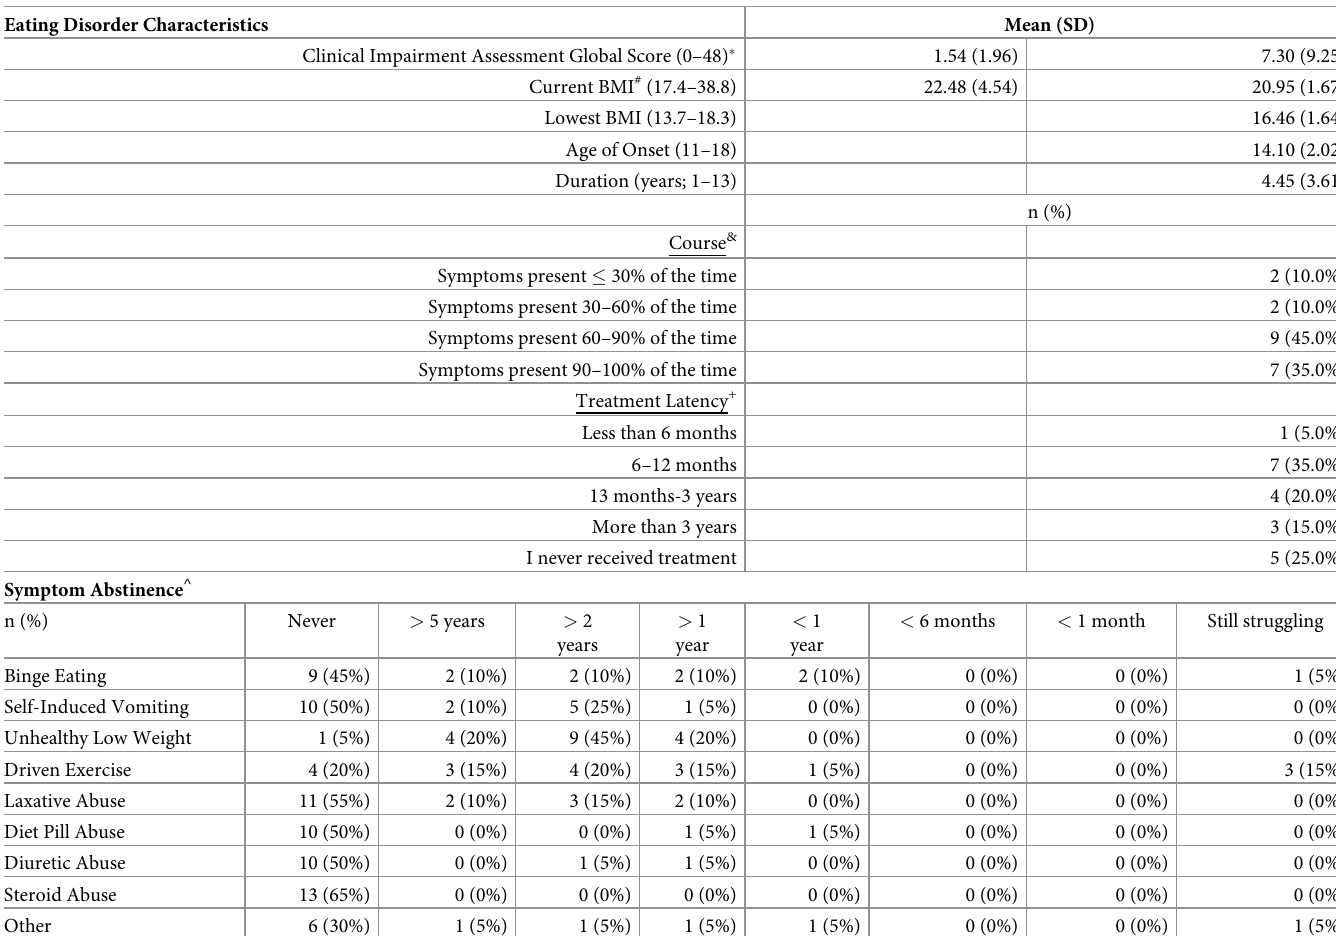
Table 2. Eating disorder characteristics of participants with a history of anorexia nervosa. Eating Disorder